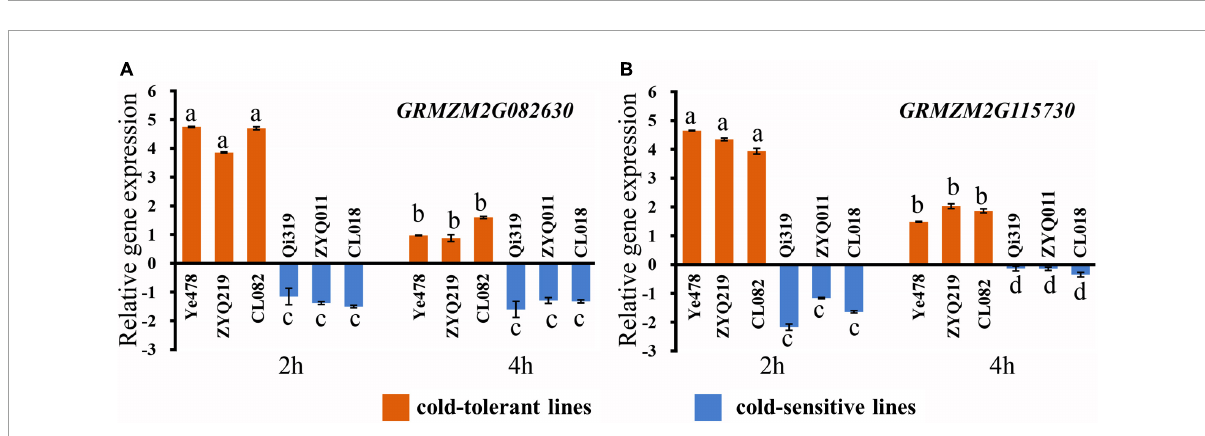
FIGURE6 Relative expression of two candidate genes. (A) Relative expression of the candidate gene GRMZM2G082630 , (B) relative expression of the candidate gene GRMZM2G115730 . Different small letters within a gene indicate significant differences between the